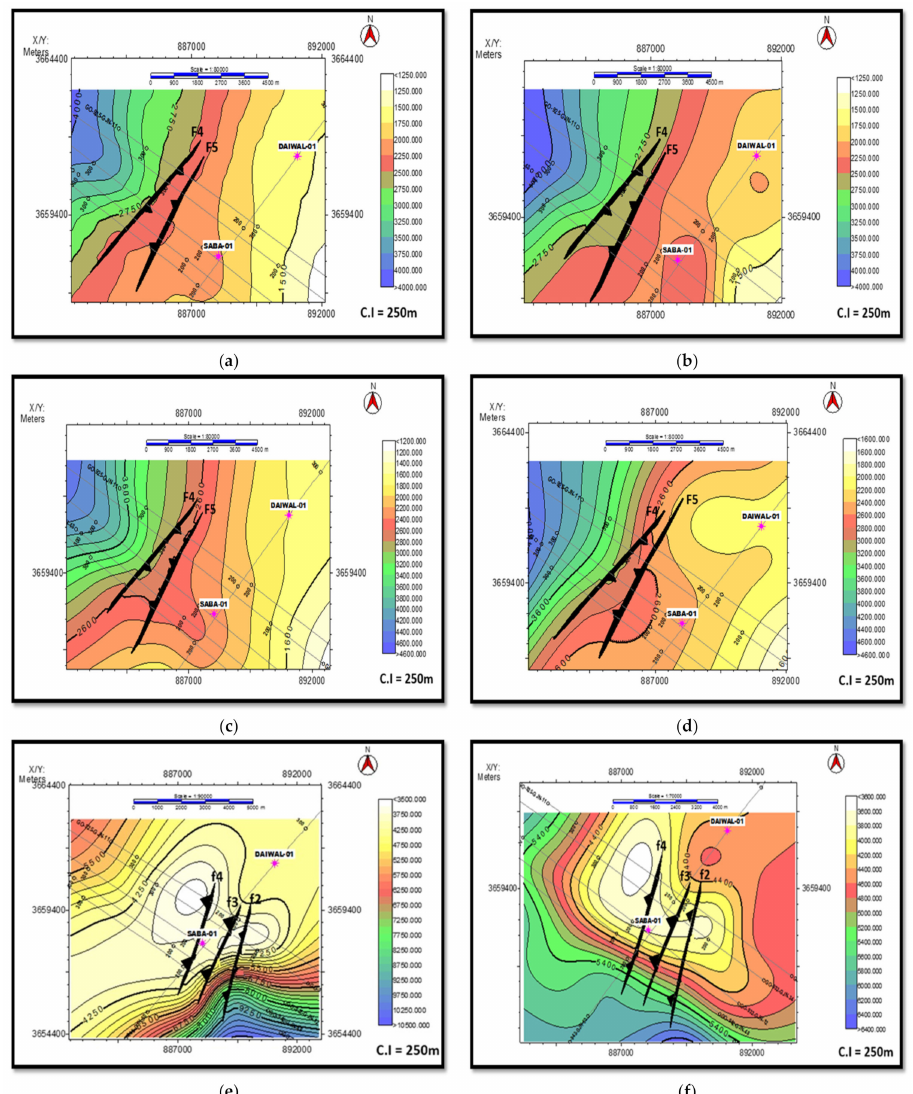
Figure 7. Depth contour maps for Contour Interval (C.I) of 250 m, for ( a ) top Eocene 1, ( b ) top Paleocene 1, ( c ) Khewra sandstone 1, ( d ) salt range 1, ( e ) top Eocene 2, and ( f ) top Paleocene 2. Both types of contour maps (time and depth) represent the subsurface structural arrangement. Only those faults that are cutting the formations and producing